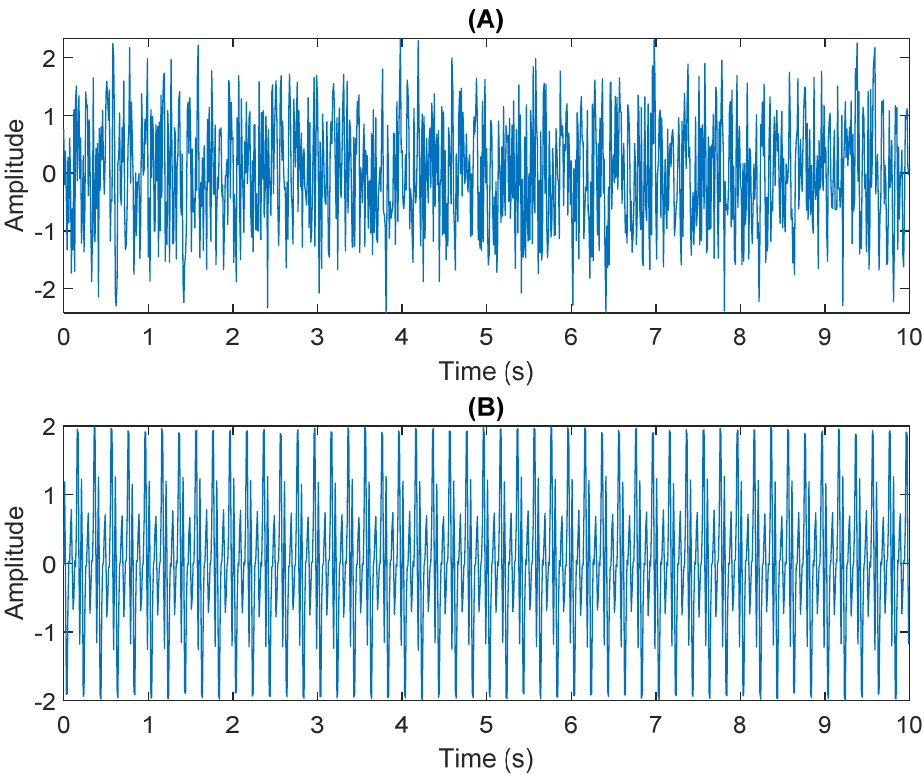
Figure 4. Hilbert Spectrum results of the VMD component obtained from the numerical simulation of the sensor.